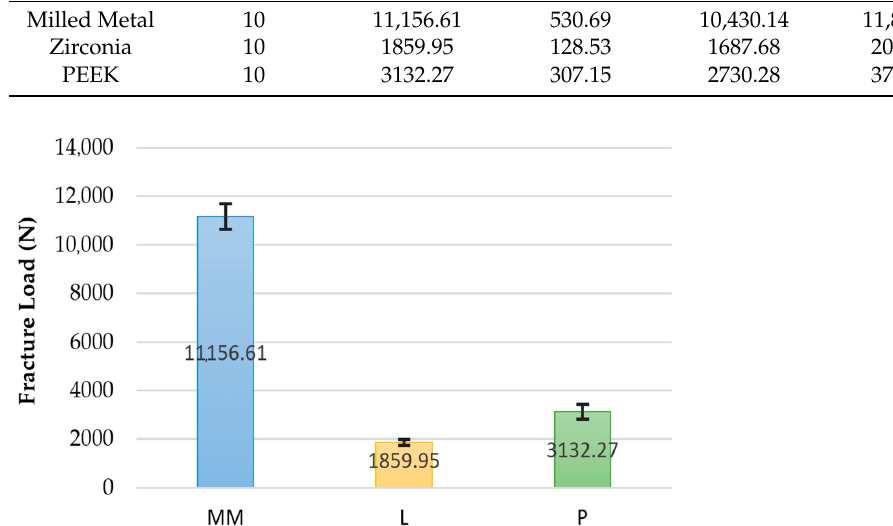
Figure 1. Graph of fracture load values among the groups (MM: milled metal; L: zirconia; P: PEEK).